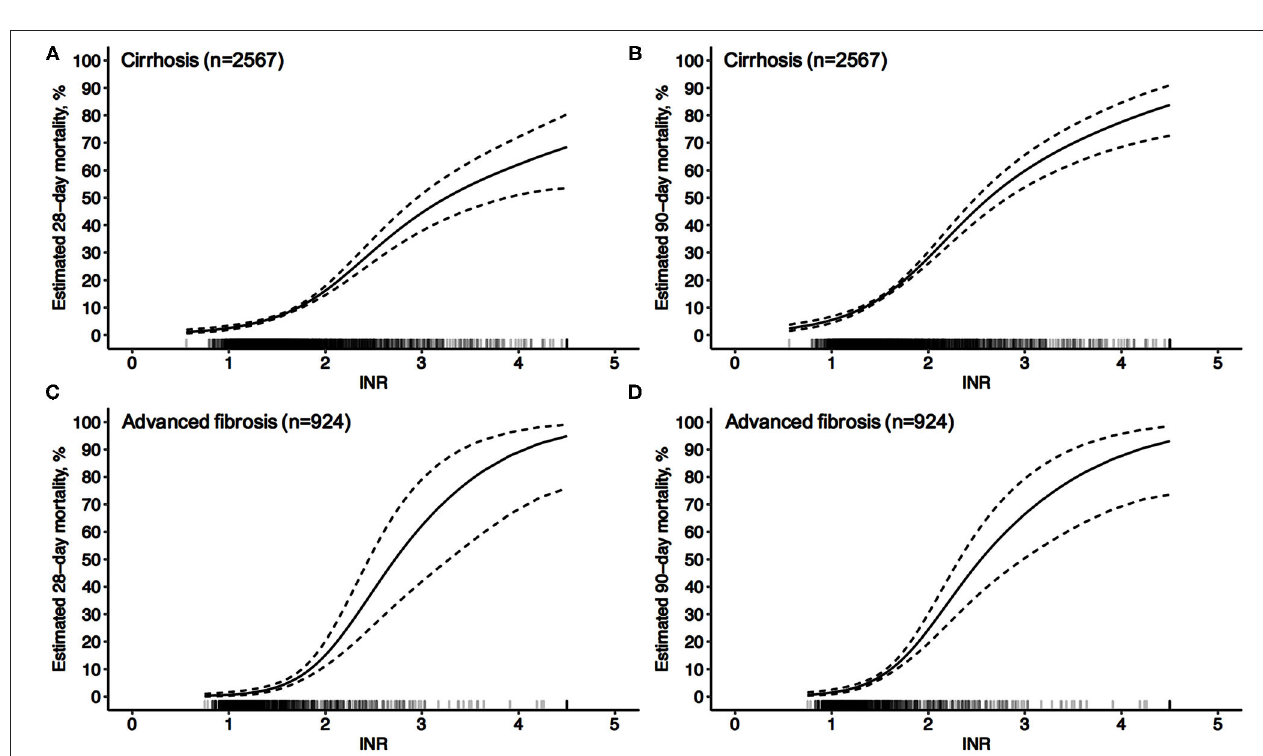
FIGURE 2 | Unadjusted probability of LT-free mortality by baseline INR in cirrhosis and advanced fibrosis. (A,B) 28-day (A) and 90-day (B) LT-free mortality by baseline INR in cirrhosis, (C,D) 28-day (C) and 90-day (D) LT-free mortality by baseline INR in advanced fibrosis.